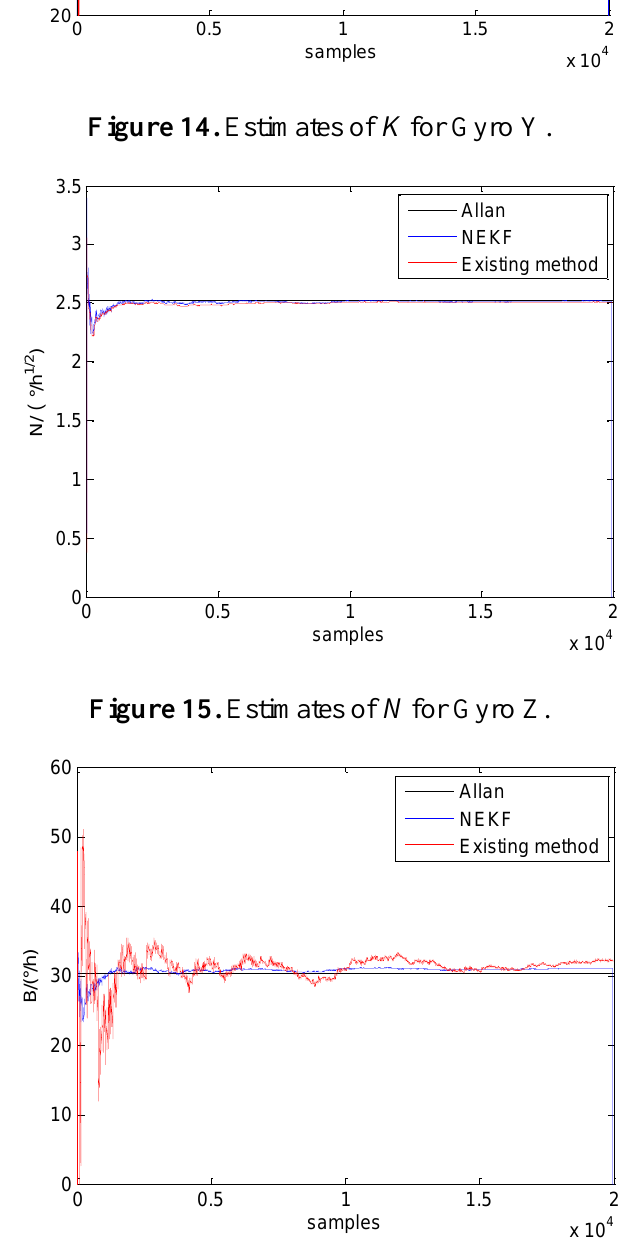
Figure 16. Estimates of B for Gyro